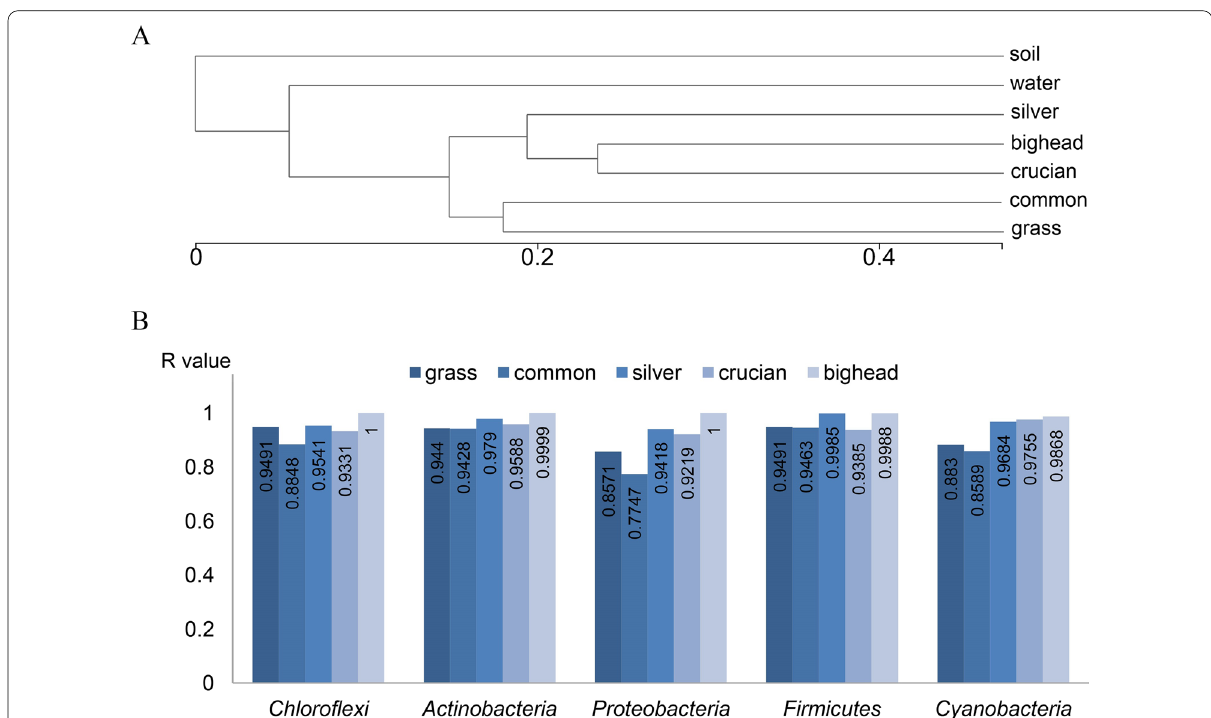
Fig. 3 A Hierarchical clustering results showing the Bray–Curtis distances between sample groups. B The results from analysis of similarity showing the Bray–Curtis distances of dominant bacterial phyla between soil and intestinal bacterial communities in each of five analyzed carp species (P < 0.01). Grass, common, silver, crucian, and bighead indicating intestinal bacterial communities in the five analyzed carp species; water and soil indicating planktonic and soil bacterial communities